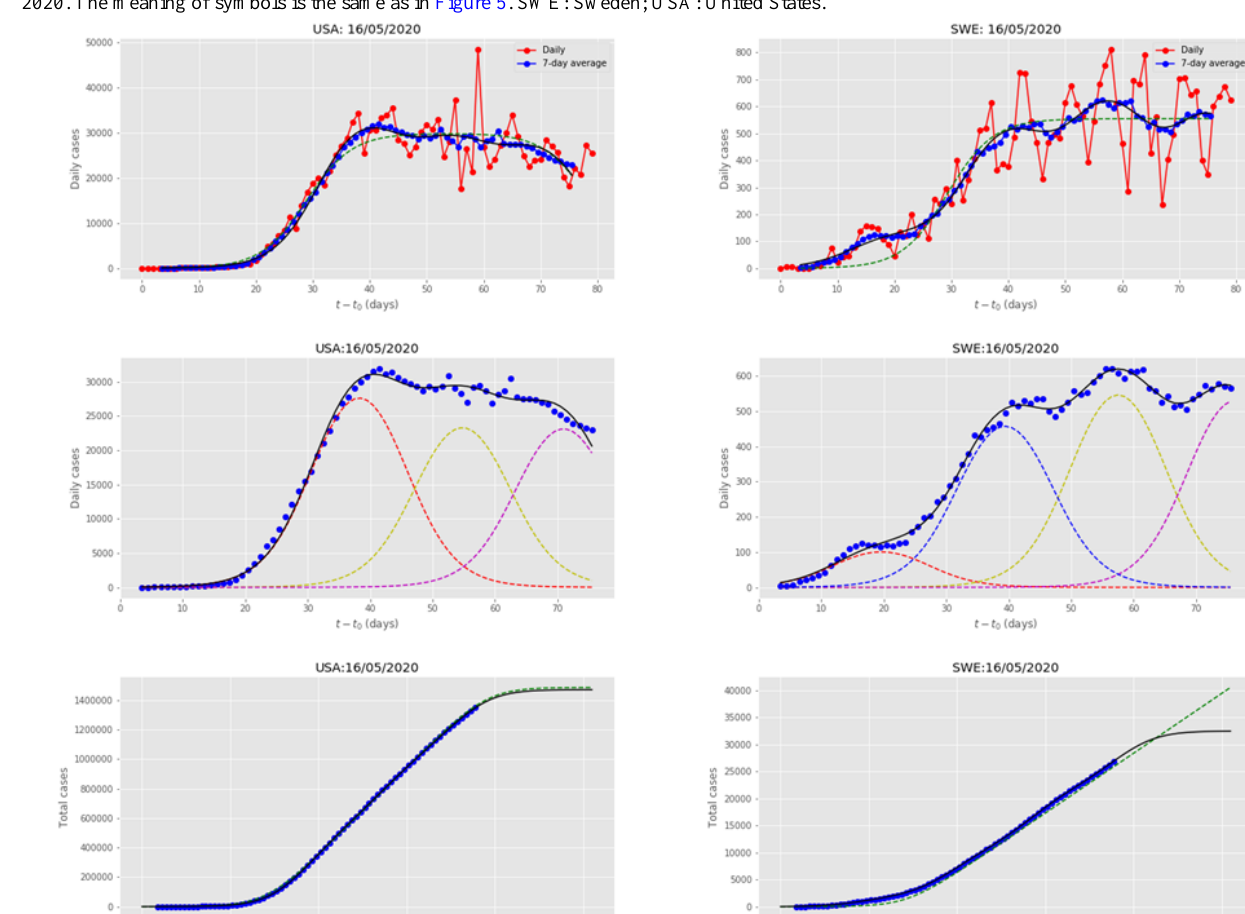
Figure 6. Results for the USA and SWE, obtained by fitting the multiple-wave forced-susceptible-infectious-removed model with data up to May